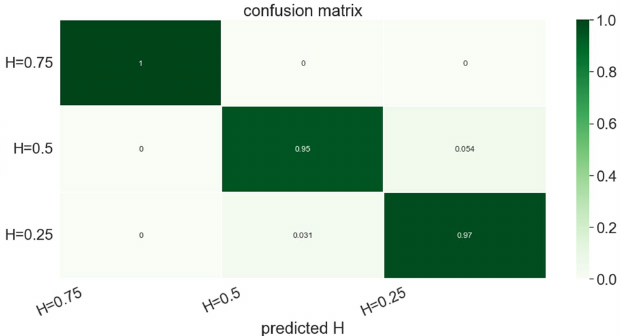
Figure 15. Confusion matrix related to the trained classifier applied to the three fractional Brownian surfaces characterized by H = 0.25, H = 0.5 and H = 0.75.